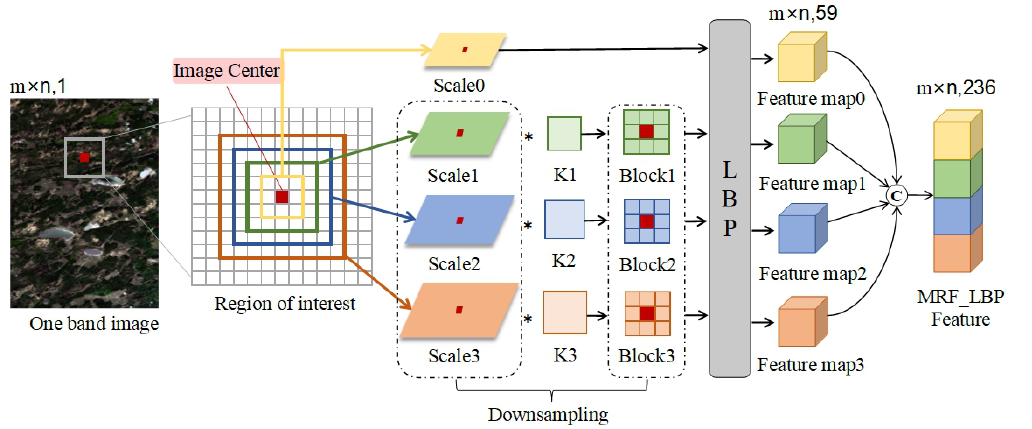
Figure 9. MSLBP structures.